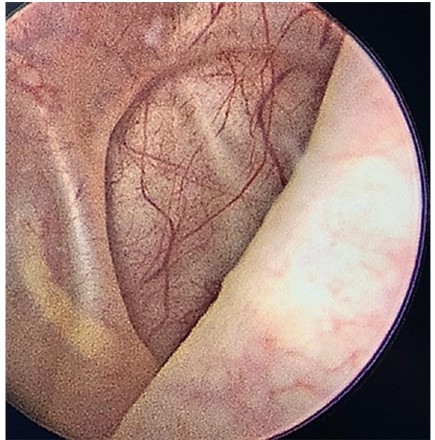
Figure 6. “Fighting” appearance of the bladder wall, with “cells and columns”.